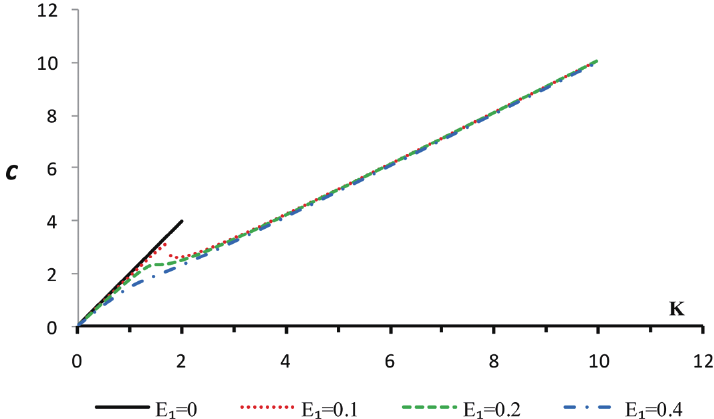
Fig. 5. Variations of c in terms of K for different values E 1 .